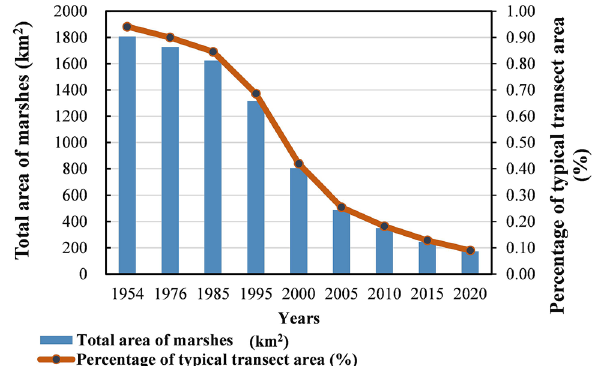
Figure 9. The change of marshes area on typical transect during 1954–2020. Figure shows the total area of wetlands and it’s percentage in sub-Sangjiang Plain is continually decrease from 1954 to